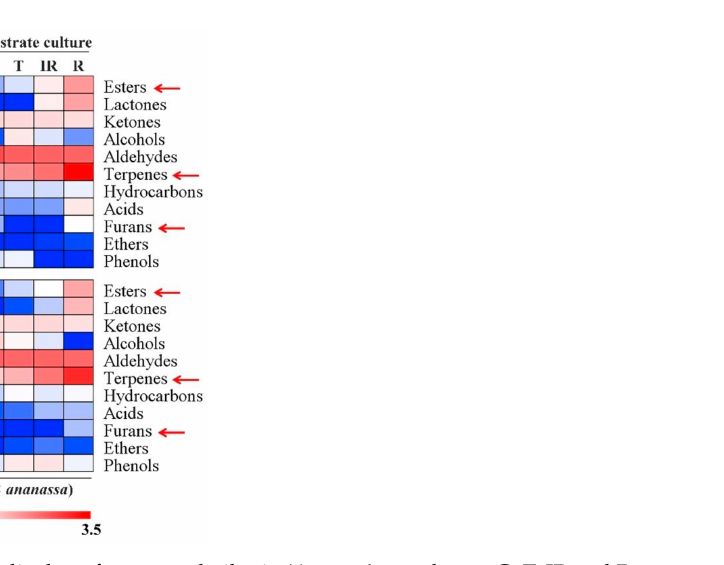
Figure 2. Heatmap display of aroma volatiles in ‘Amaou’ strawberry. G, T, IR and R represent green, turning, intermediate red and full red, respectively.